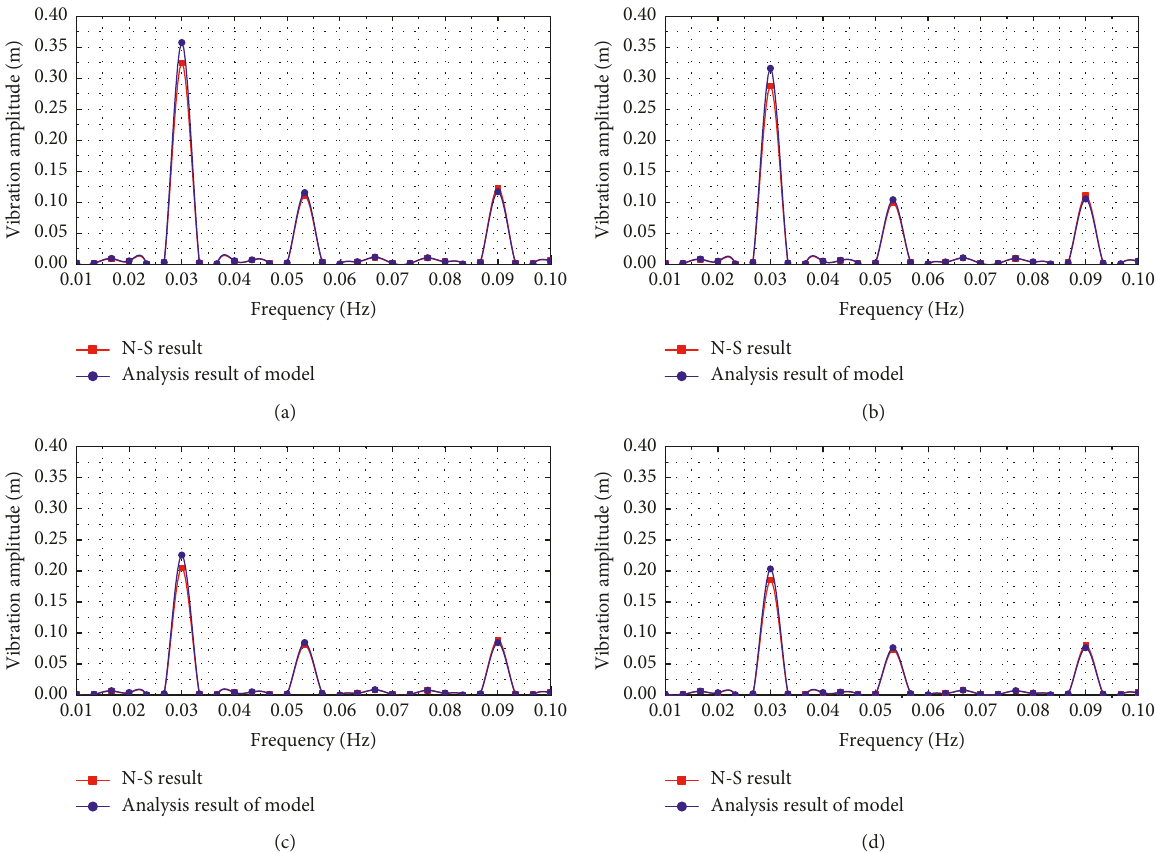
Figure 4: Curves of amplitude-frequency and phase-frequency characteristics under different damping values: (a) 0.10, (b) 0.15, (c) 0.20, and (d) 0.25.